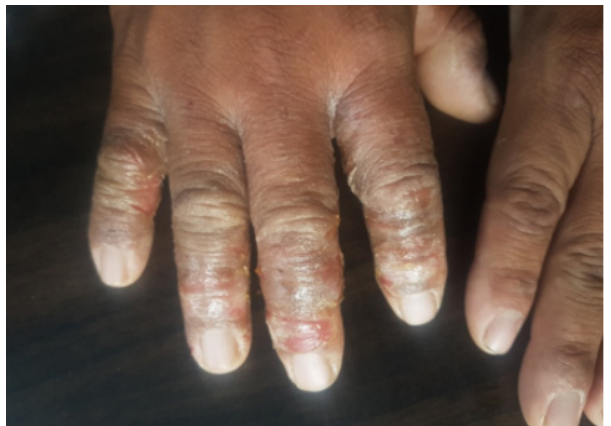
Figure 3: Irritant contact dermatitis with infection in cconstruction worker. (Permission was obtained from patient to display photo image) Occupational